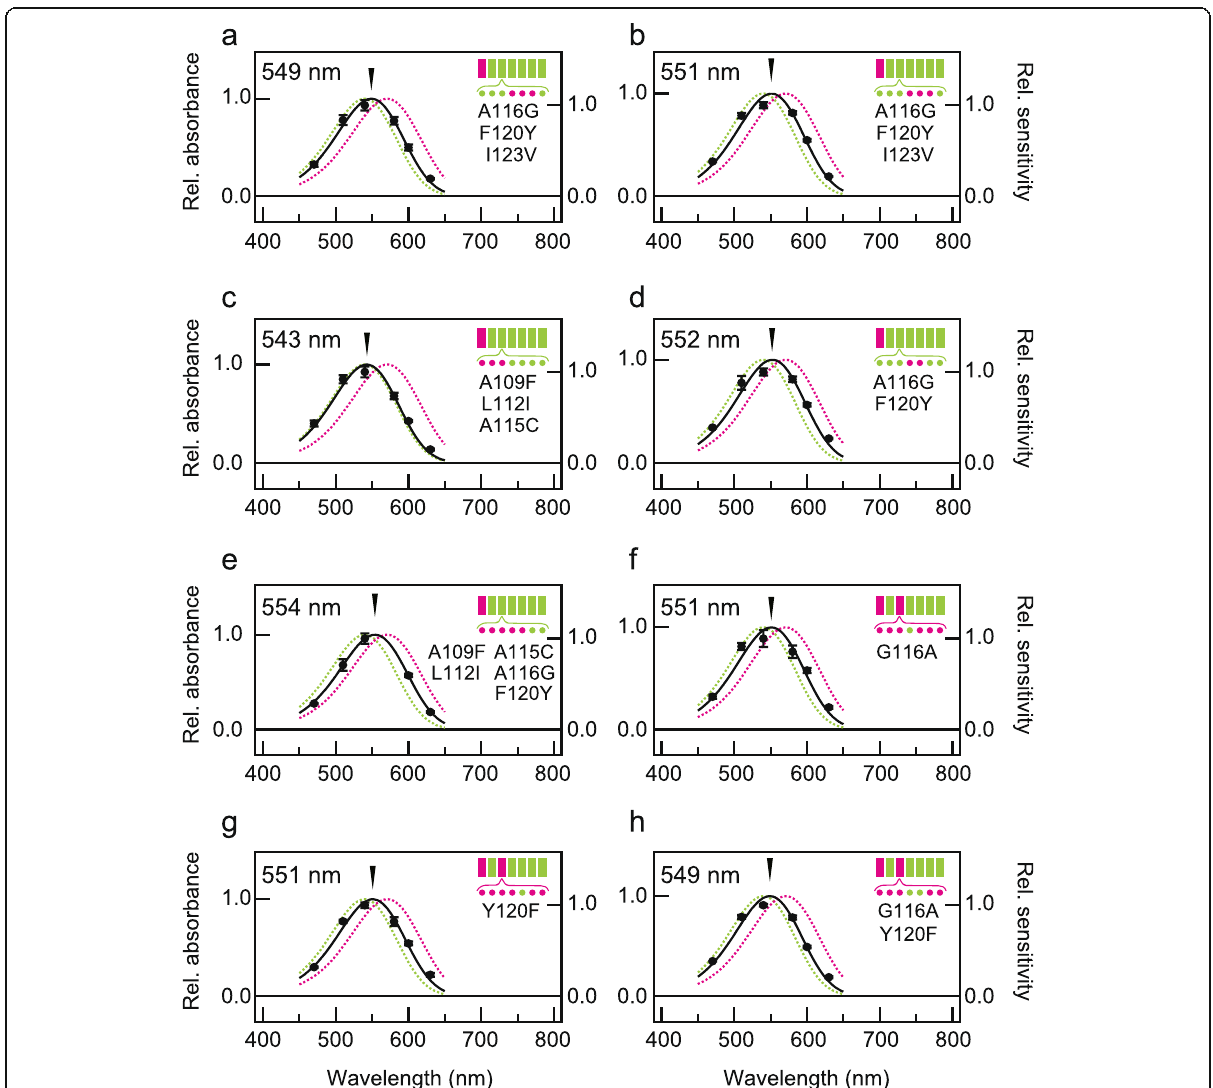
Fig. 6 Effect of multiple mutations in helix III for the red shift in a chimera Rh3(I)/Rh1(II-VII). The absorption spectra of chimeric mutants Rh3(I)/ Rh1(II-VII) having multiple mutations at positions in which amino acid residues are different between PxRh1 and PxRh3 in helix III, Rh3(I)/Rh1(II- VII)_A116G/F120Y/I123V ( a , b ), Rh3(I)/Rh1(II-VII)_A109F/L112I/A115C ( c ), Rh3(I)/Rh1(II-VII)_ A109F/L112I/A115C/A116G/F120Y ( d ), Rh3(I)/Rh1(II- VII)_A116G/F120Y ( e ), Rh3(I,III)/Rh1(II,IV-VII)_G116A ( f ), Rh3(I,III)/Rh1(II,IV-VII)_Y120F ( g ), Rh3(I,III)/Rh1(II,IV-VII)_G116A/Y120F ( h ) estimated by heterologous action spectroscopy. Solid circles represent the mean relative sensitivities of cultured cells expressing each chimeric mutant at each wavelength of light irradiation ( n = 3) and black curves indicate estimated absorption spectra. The error bar shows standard error. The absorption spectra of PxRh1_Gs and PxRh3_Gs are also indicated by green and magenta broken curves, respectively. Schematic drawings of seven transmembrane structure of butterfly opsins are also shown, in which helices and amino acid residues of PxRh1 and PxRh3 are indicated by green and magenta,